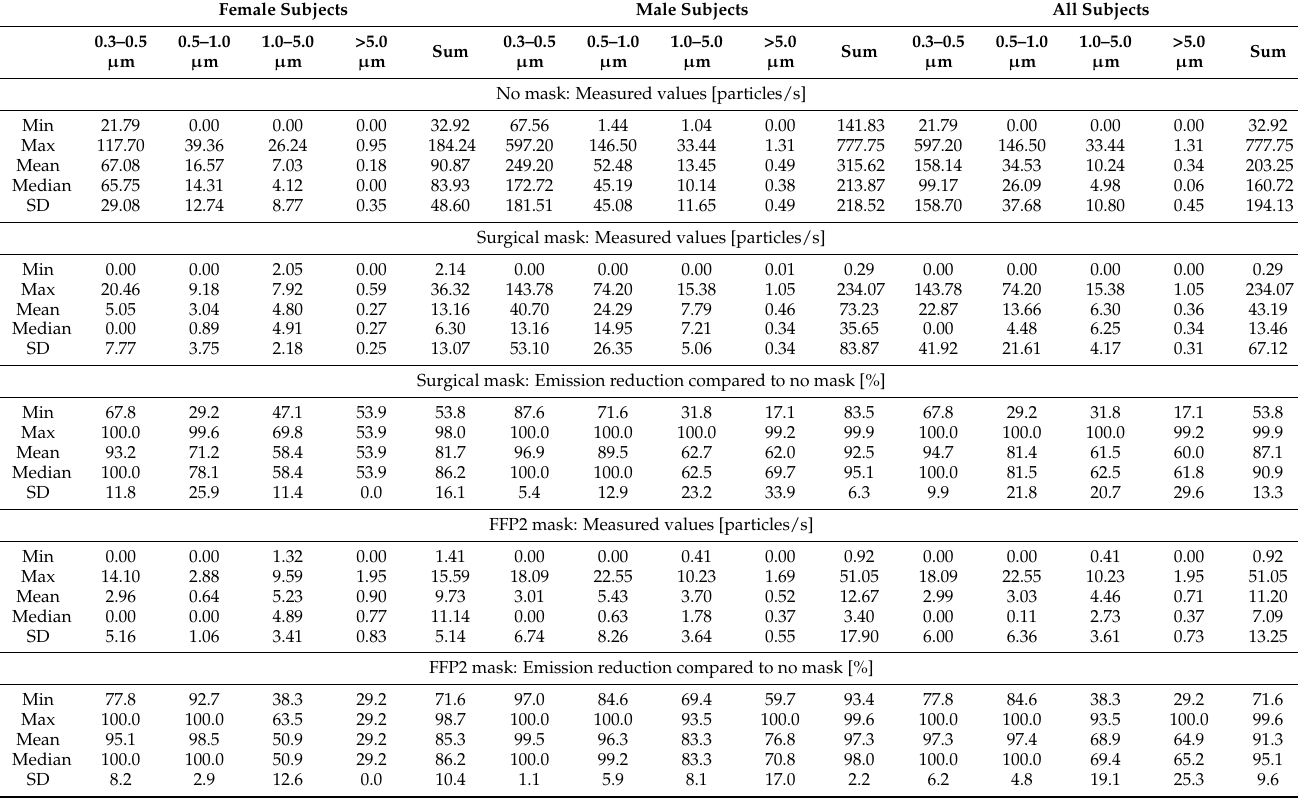
Figure A2. The mean emission rate of the exhaled particles and their confidence intervals ( α = 0.05) from all test subjects when wearing no mask, surgical mask, and FFP2 mask. Table A1. The minimum, maximum, mean, median, and standard deviation of the measured particles during the investigated mask conditions and the reduction efficiency of the tested masks.